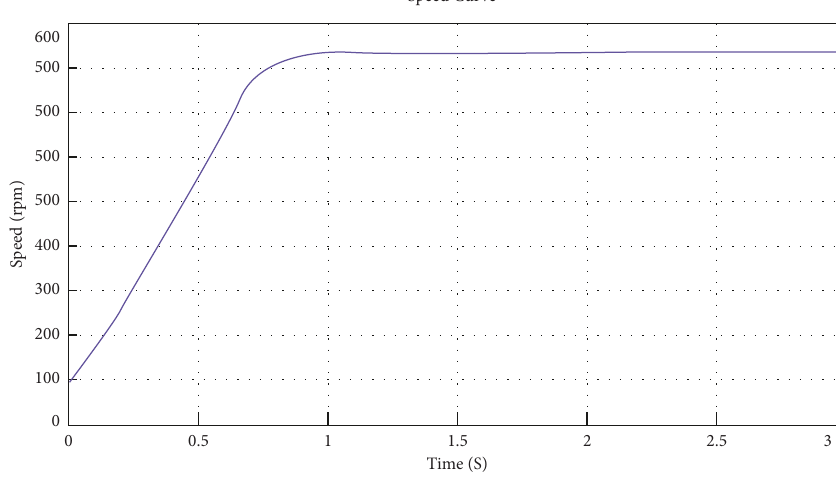
Figure 10: Speed vs time.